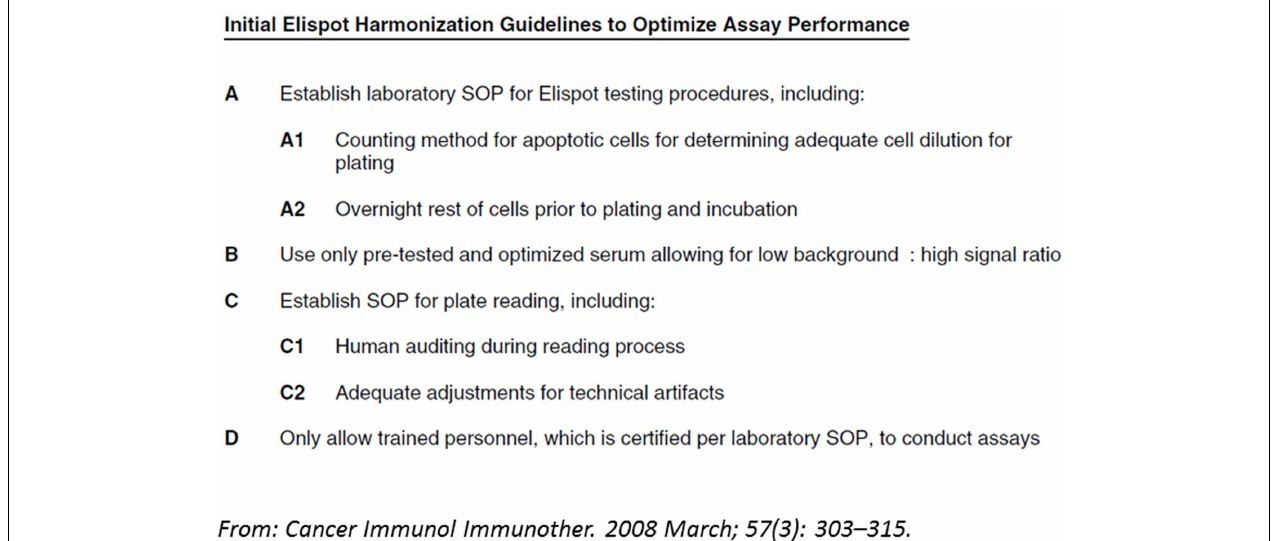
FIGURE 2 | Example of a harmonization guideline: initial guidelines for harmonization of the ELISPOT assay to optimize assay performance and reproducibility derived from two international proficiency panels, based on their findings and trends observed .